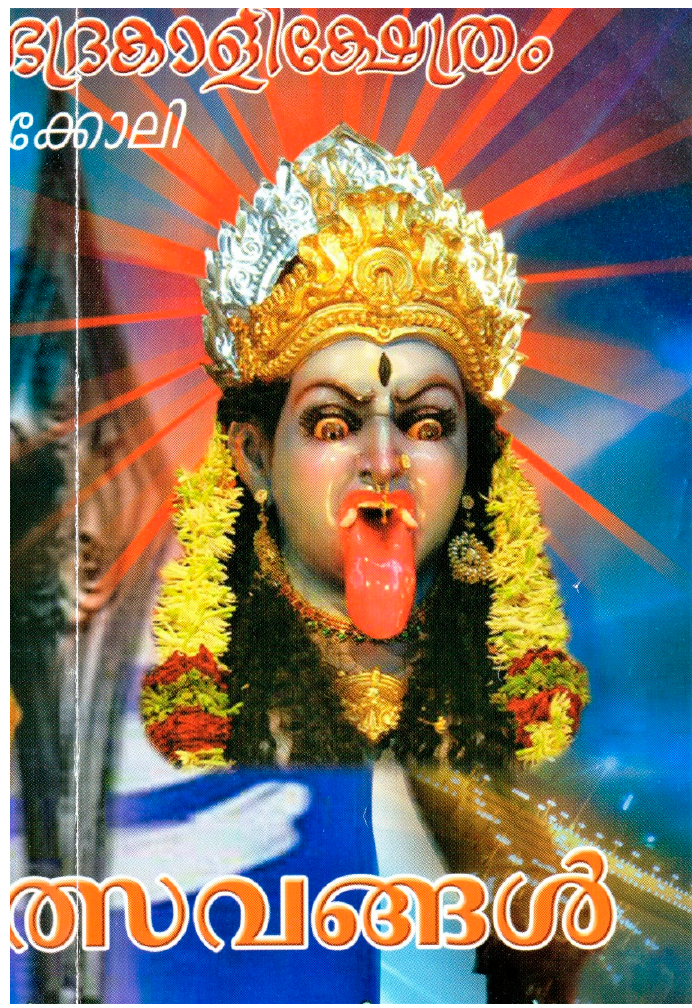
Figure 2. Detail from a festival leaflet (Bhadrak ā ḷ i temple of Idakkoli, Kottayam district).